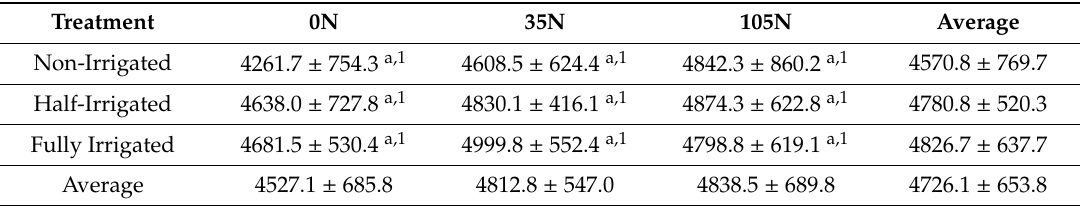
Table 15. The e ff ect of di ff erent fertilization rates on the yield (kg ha − 1 ) of soybean (cv. Pannonia Kincse) under di ff erent irrigation regimes, averaged among 2017, 2018, and 2019 in Debrecen, Hungary.